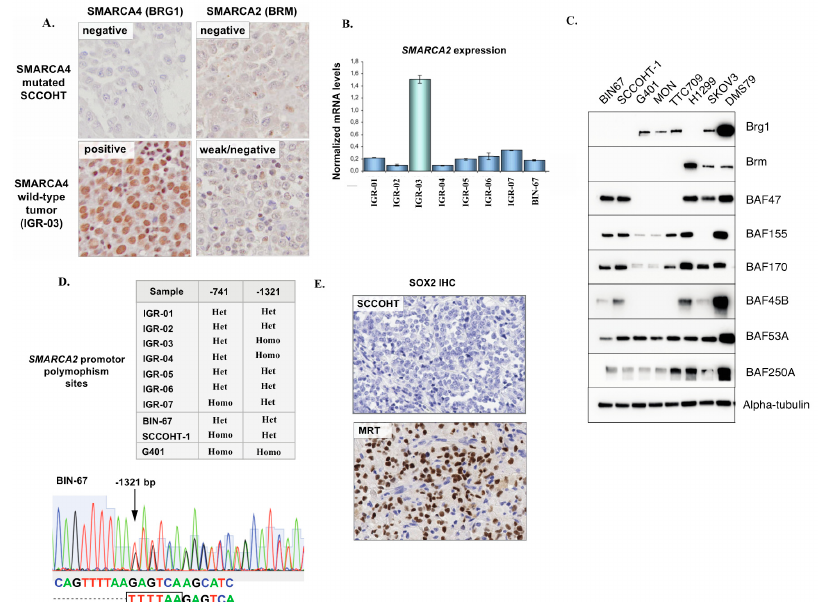
Figure 2. SMARCA4 and SMARCA2 expression in SCCOHT. ( A ) Representative SMARCA4 and SMARCA2 immunohistochemistry in a SMARCA4 mutated SCCOHT and in the one SMARCA4 wild-type. Tumor harboring concomitant ARID1A and ARID1B mutations (IGR-03). ( B ) Real-time RT-PCR for SMARCA2 in patient tumor samples from this study and in a SCCOHT cell line (BIN-67); ( YWHAZ/GUSB/HPRT1 ). ( C ) Western blot showing expression of several SWI/SNF expression levels are normalized to three housekeeping genes ( YWHAZ / GUSB / HPRT1 ). ( C ) Western blot showing expression of several SWI / SNF subunits in SCCOHT cell lines (BIN-67, SCCOHT-1) compared to MRT (G401, MON, TTC709), SMARCA4 -mutated lung cancer (H1299), high-grade endometrioid adenocarcinoma of the ovary (SKOV3) and neuroendocrine small cell lung cancer (DMS79) cell lines. ( D ) Results of Sanger sequencing of the SMARCA2 promoter insertional polymorphism sites, and an example of a heterozygous polymorphism status ( − 1321 site) in BIN-67 cells. ( E ) Representative IHC for SOX2 in SCCOHT and a positive control (SOX2-positive MRT) in patient FFPE tumor